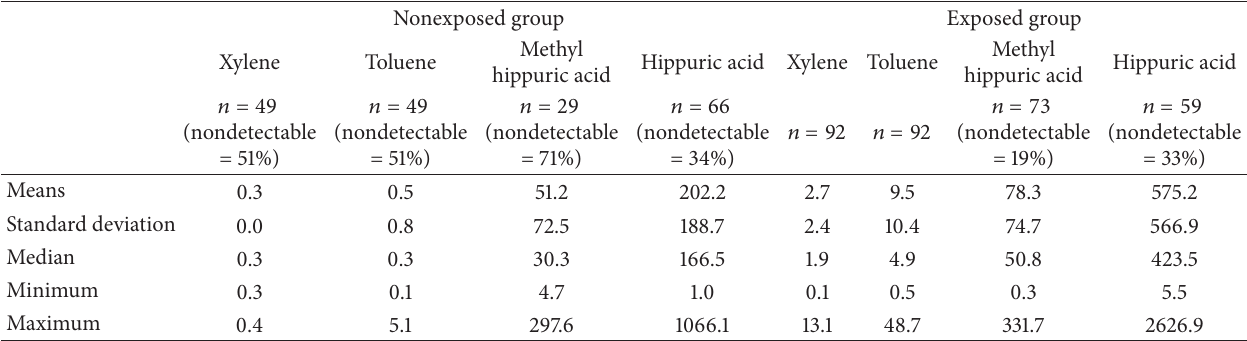
Table 3: Level of xylene and toluene exposure in work environment (ppm) and urinary metabolite (mg/gram creatinine) in non-exposed and exposed group.